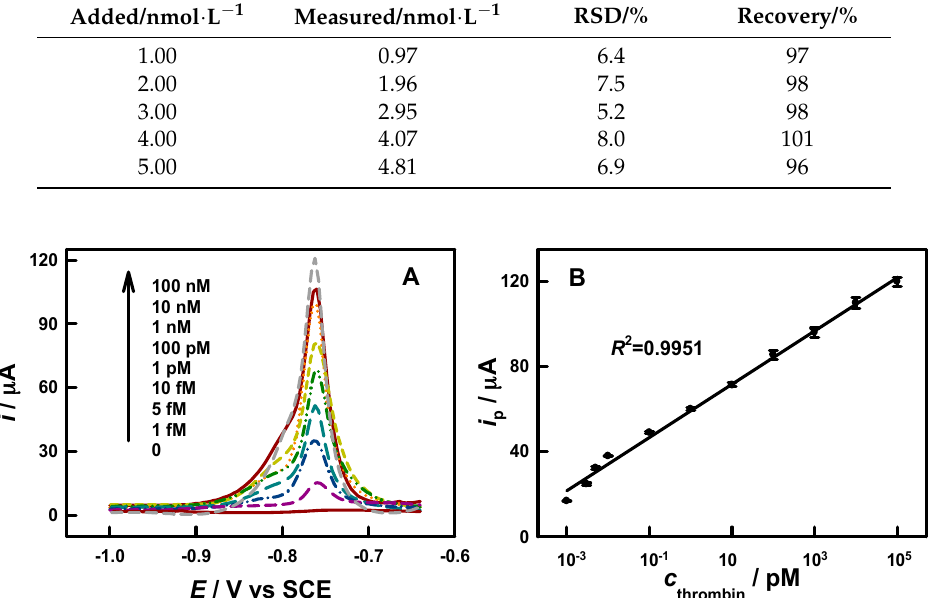
Figure 5. Differential pulse ASV curves for thrombin aptamer-electrodes ( A ) and corresponding calibration curves ( B ) using our protocol ( n = 3).